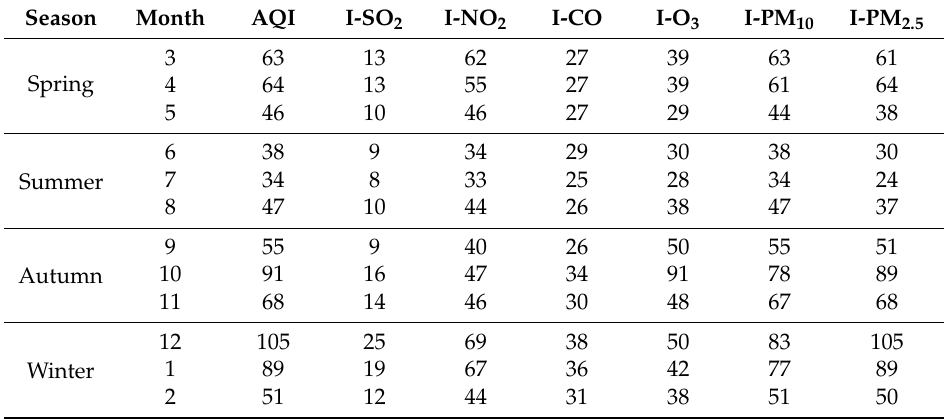
Table 3. Monthly AQI and IAQIs for air pollutants in Shenzhen from March 2013 to February 2014. Season Month AQI I-SO